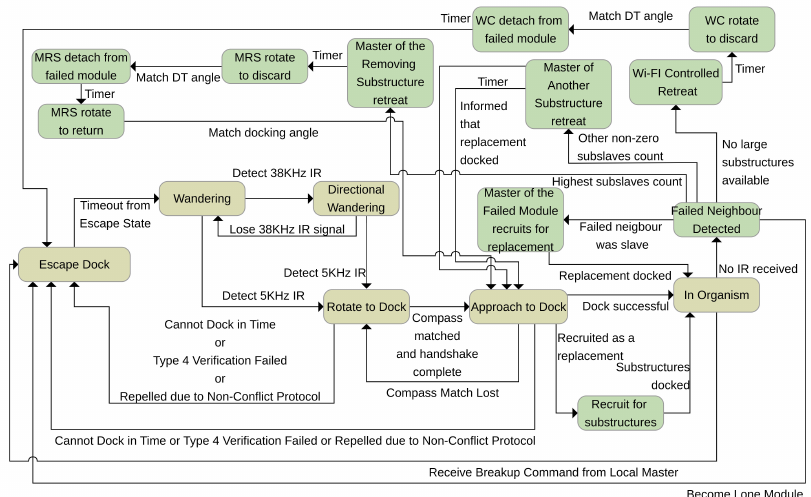
Figure 11. A simplified diagram of the FSM underlying the self-repair controller; states not present in the self-assembly controller are highlighted in